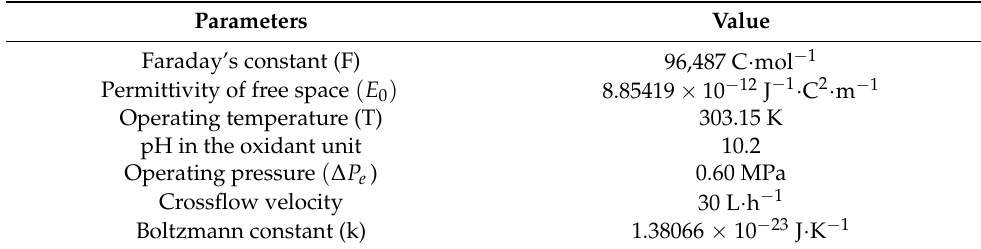
Figure 2. Ion transport across the organic-inorganic NF_PAN_Ti membrane. Table 1. Basic parameters used in the model computation